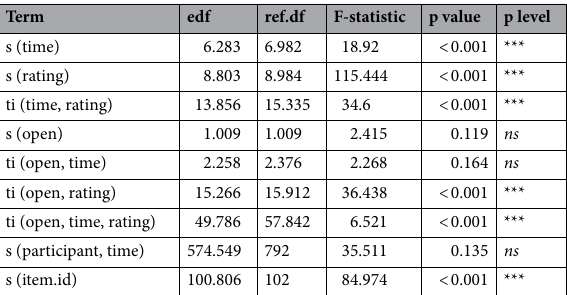
Table 4. Summary output for the GAMM modelling participants’ pupil sizes in response to morpho-syntactic errors and with their Openness score as a predictor.